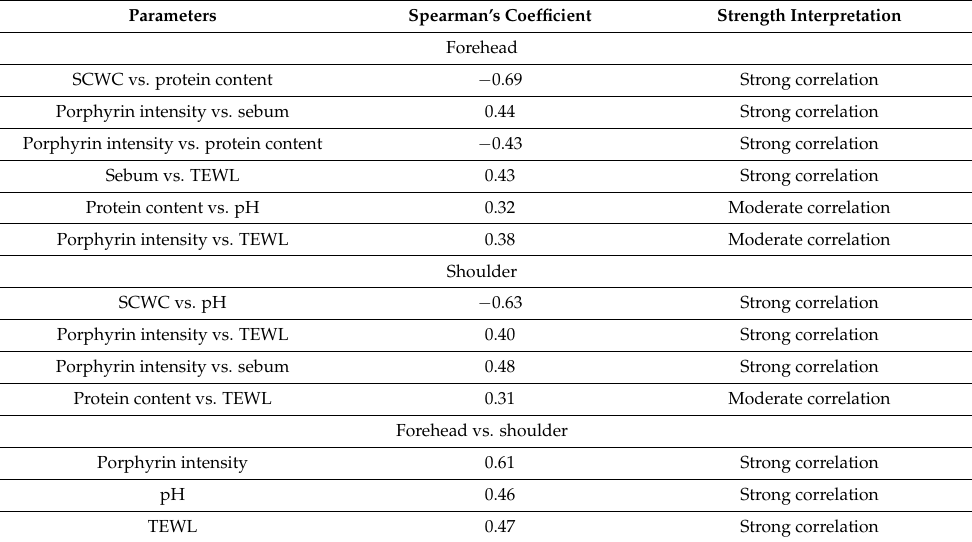
Table 3. Spearman’s correlation coefficient comparison and interpretation of the correlation between parameters The value ranges between +1 and − 1, where 1 is a total positive correlation and − 1 is a total negative